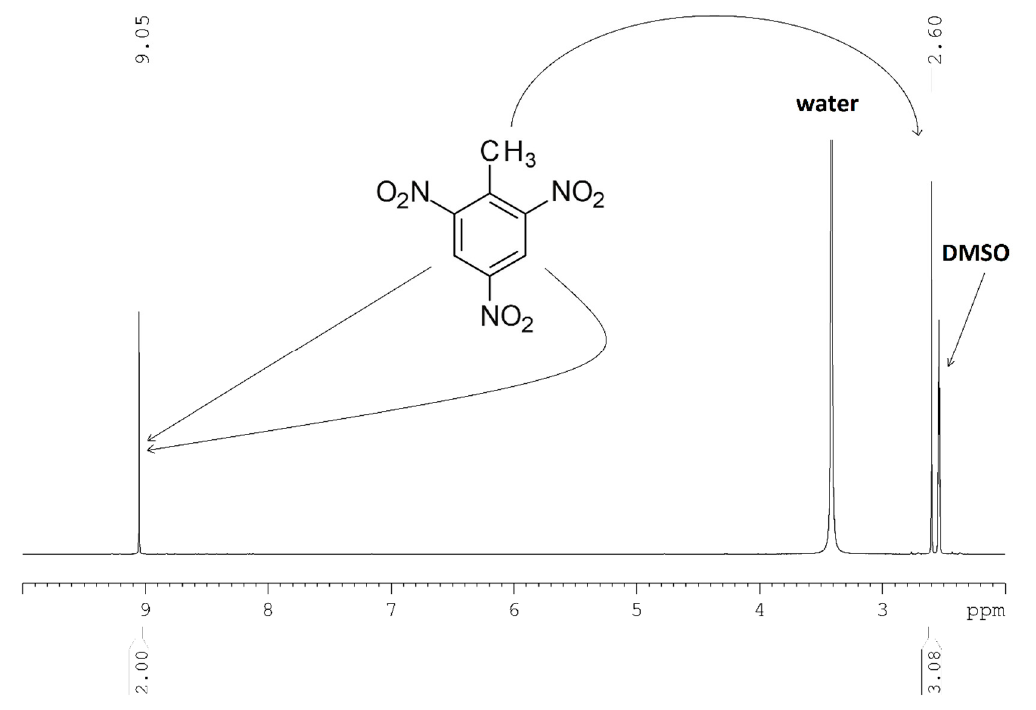
Figure 5. 1 H NMR spectrum of the synthesized TNT using flow chemistry in DMSO-d 6 .